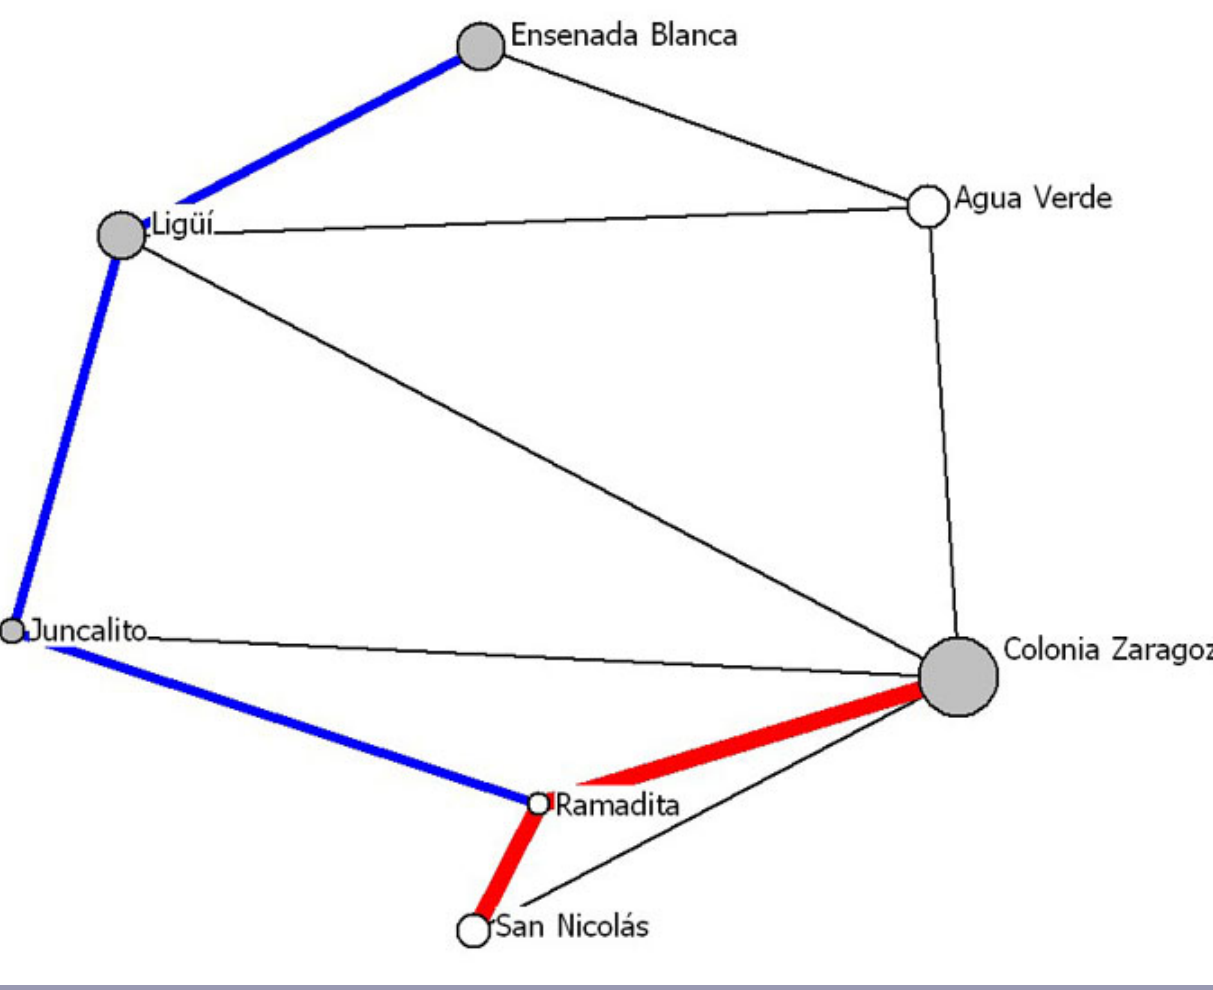
Fig. 5. Multi-dimensional scaling plot showing the linking structure among the seven communities. The size of each node (community) is proportional to the number of fishers considered in each community; communities with high resource scarcity are shown with gray circles and communities with low resource scarcity are shown with white circles. The thickness of intercommunity links is proportional to the ratio of the measured vs. the expected number of relations. Thin line < 0.5 in black, medium line < 1 in blue, thick line > 1 in red. Ratio values less than 0.1 were